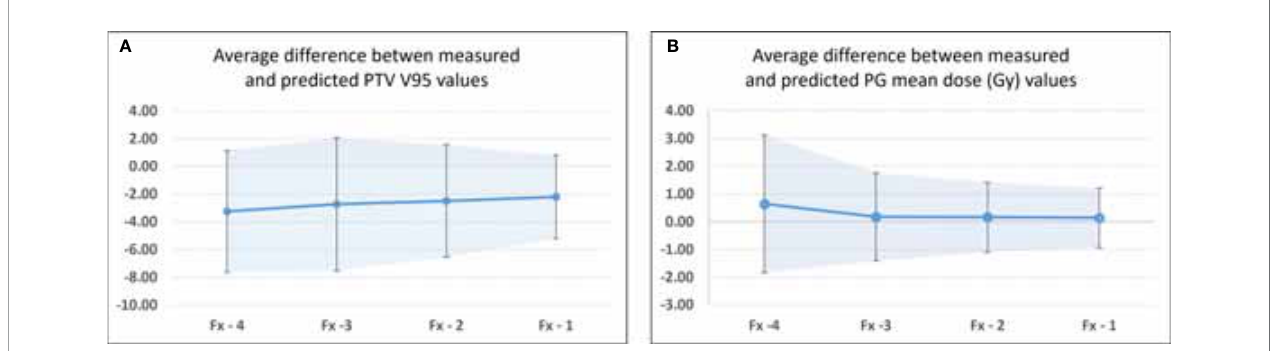
FIGURE 5 | Differences between measured and predicted values at threshold crossing for fl agged studies for (A) PTV V 95 and (B) PG D mean . Fx identi fi ed threshold- crossing fraction. Fx-i represents the last fraction that was processed to obtain the model predicted value. In this case, Fx-4 represents the fi rst fraction for which a